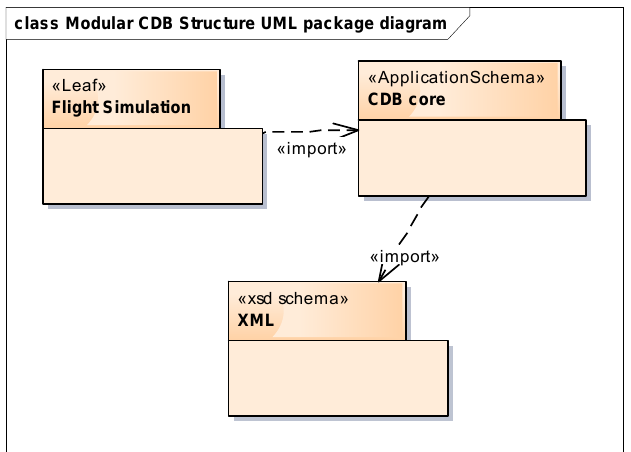
Figure 11. The overall CDB is split into a core module and extensions which have a mandatory dependency on the core.